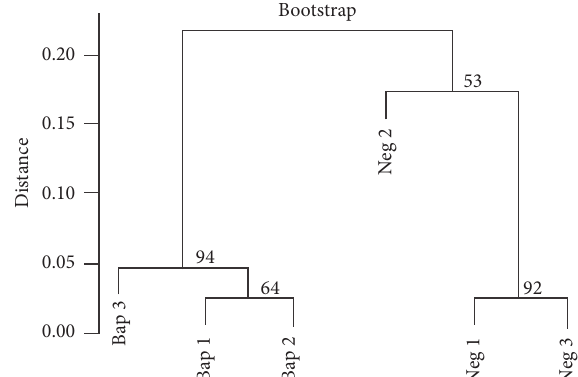
Figure 1: Gene-based correlation dendrogram between the ex- perimental (Bap) and the control groups (Neg). The number in the branches indicates bootstrap support.